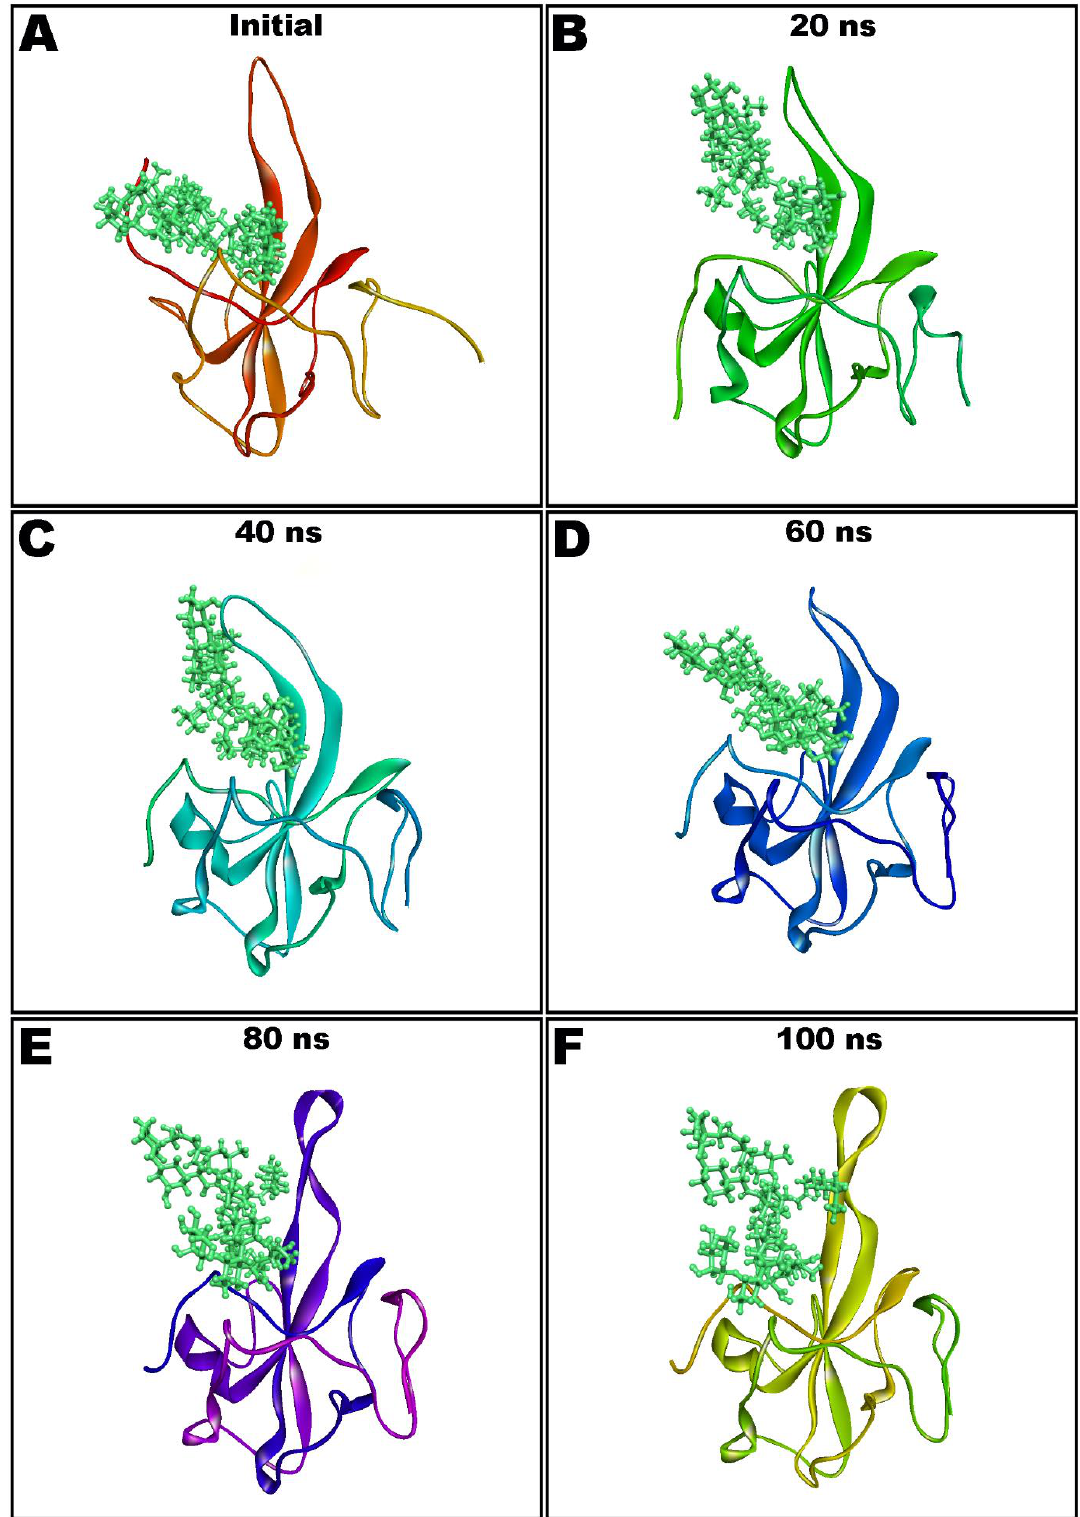
Figure 6. Molecular dynamics (MD) simulation snapshots of teicoplanin (shown as ball and stick style in green color) in complex with nucleocapsid protein N-domain (depicted as solid ribbon) showing conformational stability (Initial: A ; after 20 ns: B ; 40 ns: C ; 60 ns: D ; 80 ns: E ; and 100 ns: F ).